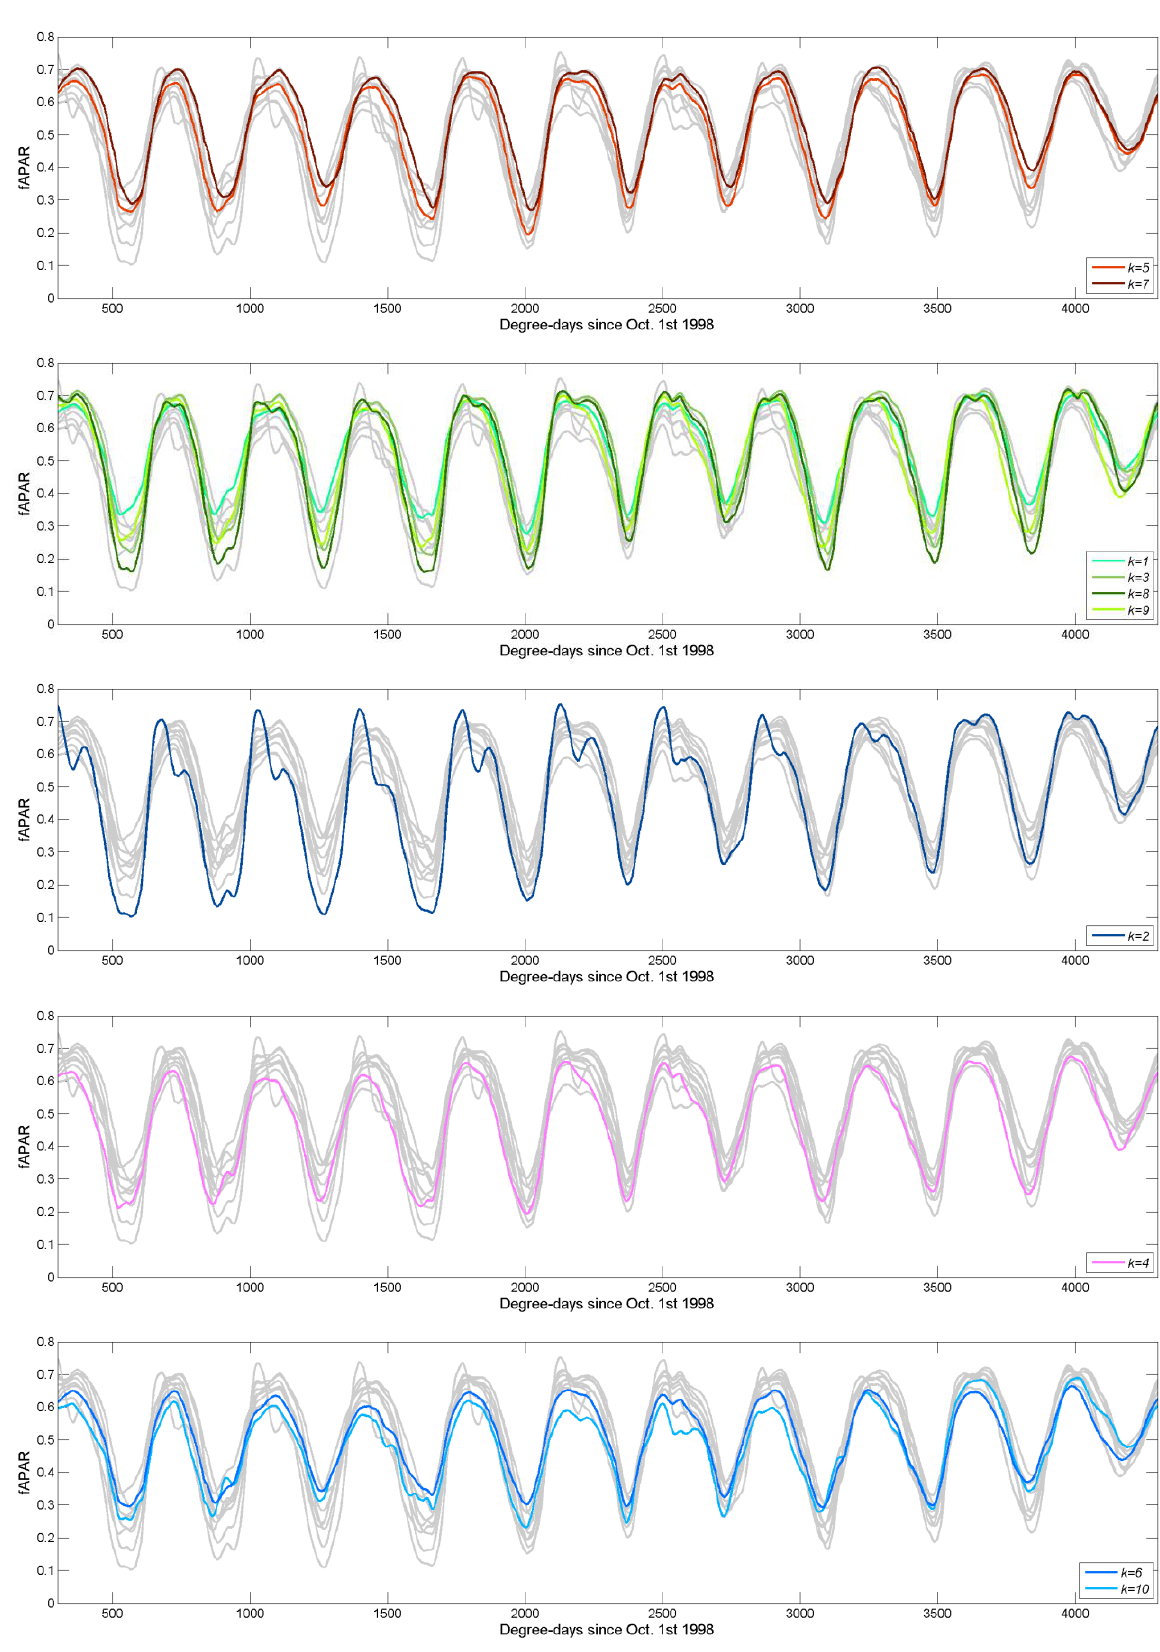
Figure 9. Median temporal profile of the 10 k- means clusters. The colors correspond to those in Figure 8. The grey profiles represent the other